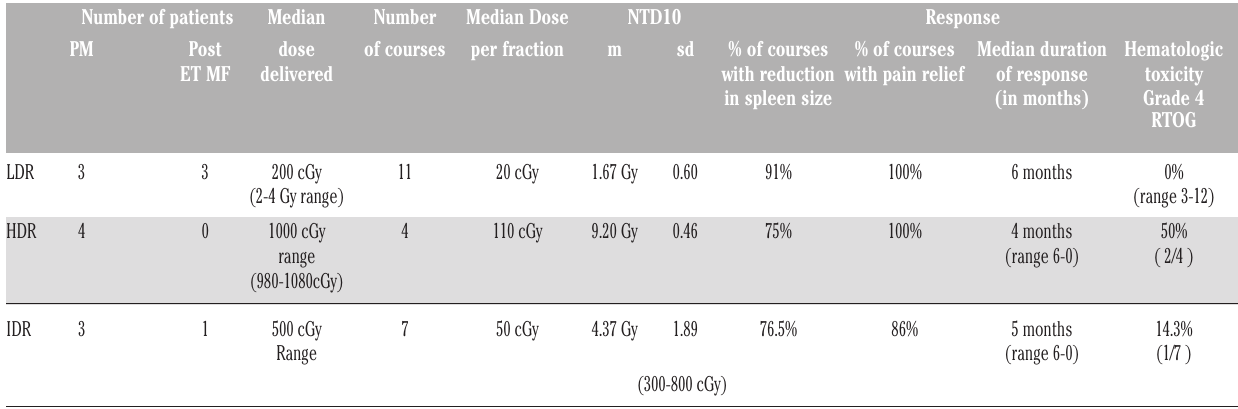
Table 2. Splenic irradiation results (by NTD